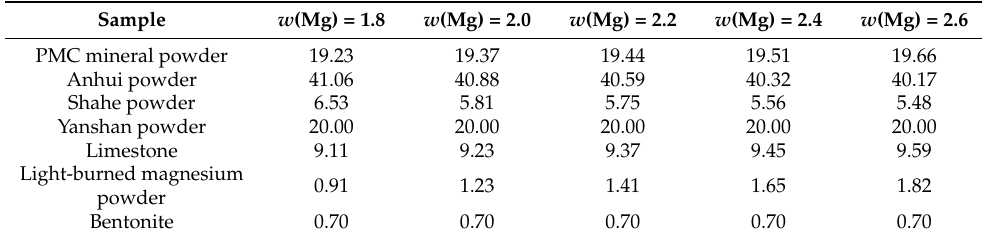
Table 6. Adjustment of Mg content and ore blending scheme